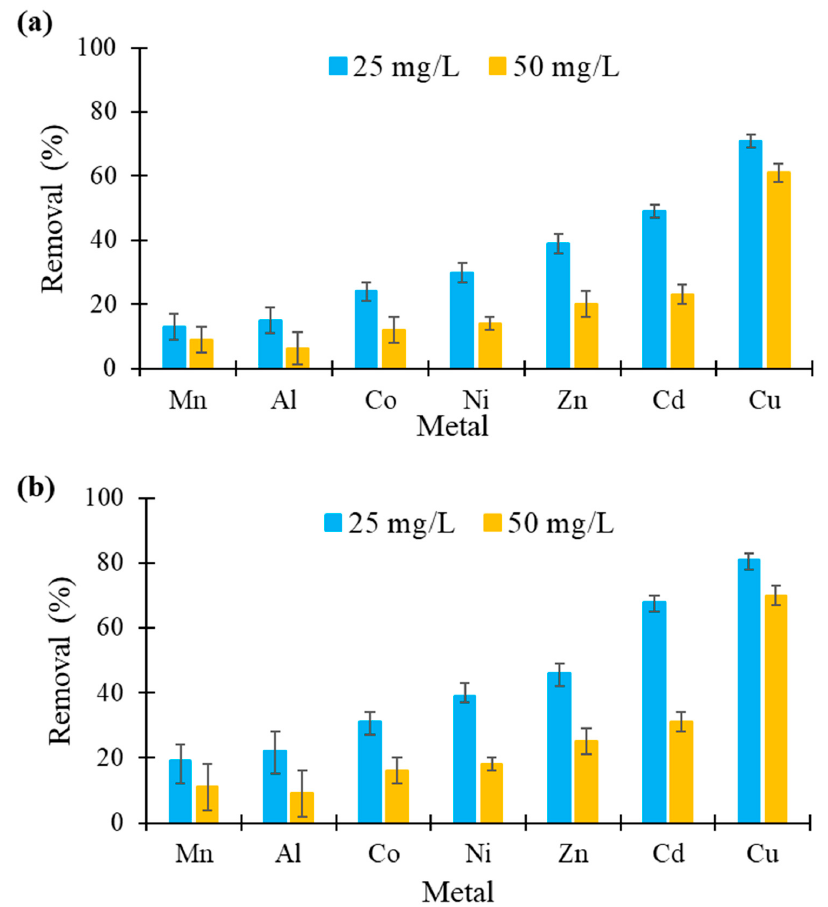
Figure 8. Comparison of metal removal (in %) from a solution containing a mixture of seven met- als at two concentrations by ( a ) hemp- and ( b ) flax-based felts (other conditions: 1 g of felt in 100 mL of solution; initial concentration of each metal in solution, 25 or 50 mg/L; contact time, 60 min; agitation speed, 250 rpm; temperature, 22 ± 1 °C; n = 3).